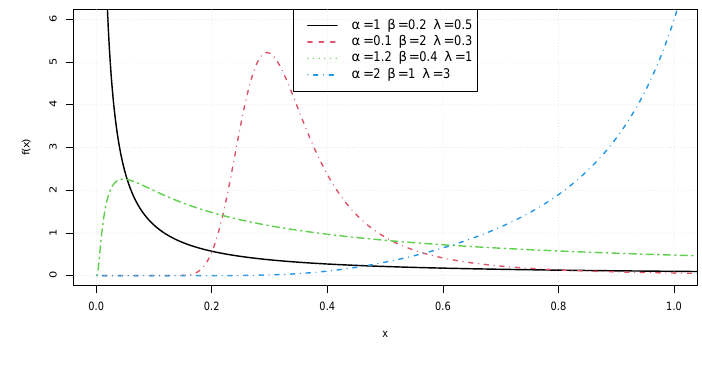
Figure 1 – Density function of the MOEUGD for different values of the parameters.